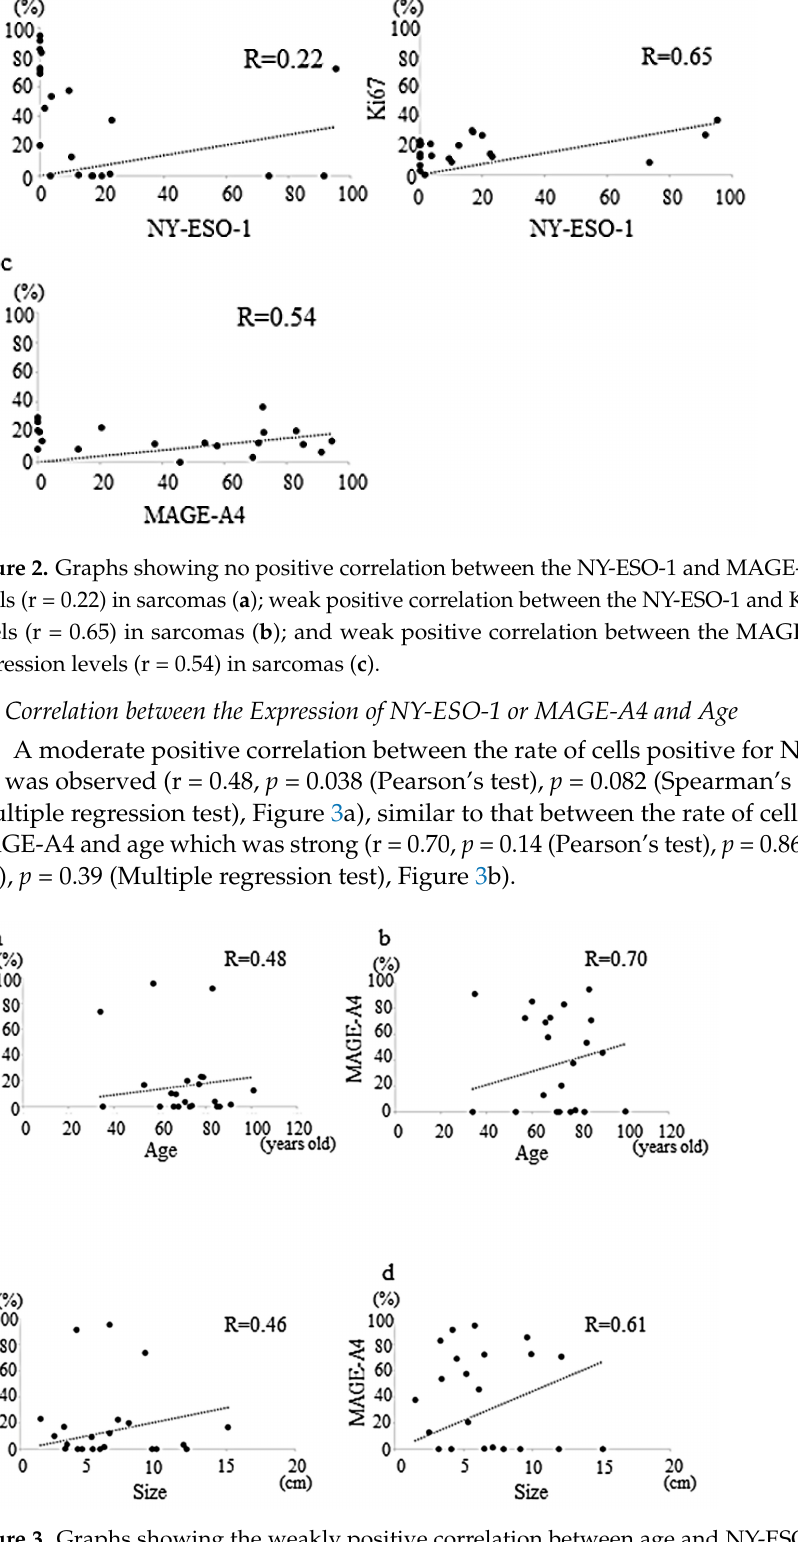
Figure 3. Graphs showing the weakly positive correlation between age and NY-ESO-1 expression (r = 0.48) in sarcomas ( a ); weak positive correlation between the age and MAGE-A4 expression (r = 0.70) in sarcomas ( b ); weak positive correlation between the tumor size and NY-ESO-1 expression (r = 0.46) in sarcomas ( c ); weak positive correlation between the tumor size and MAGE-A4 expression (r = 0.61) in sarcomas ( d